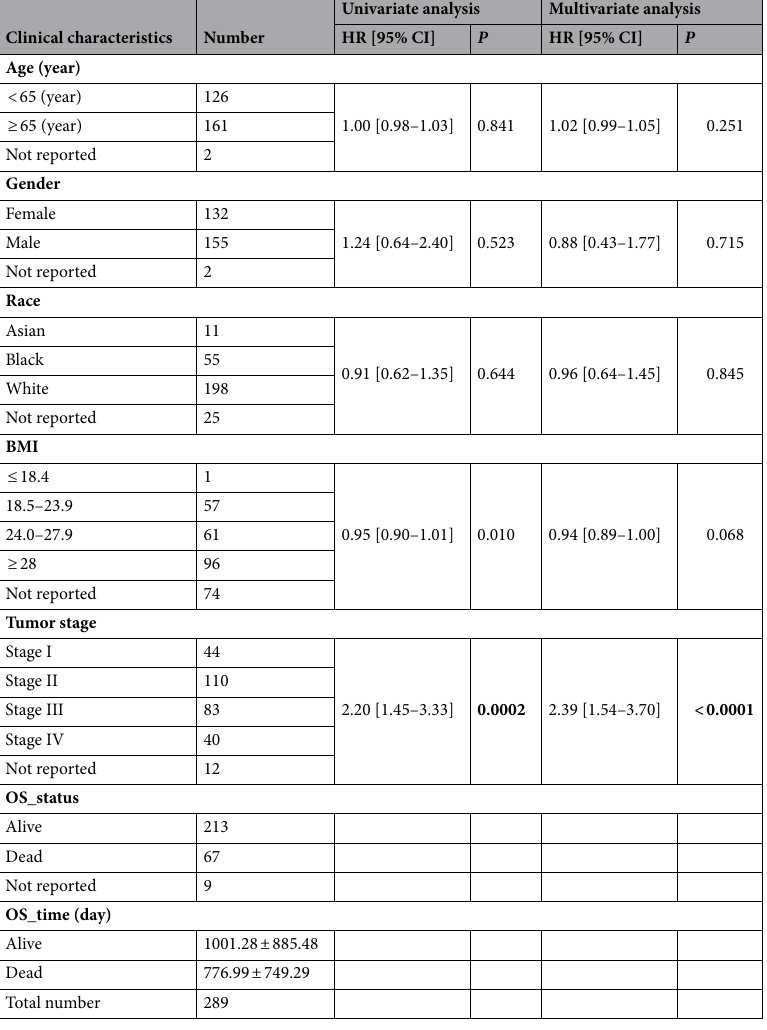
Table 1. Clinical characteristics of COAD cases (data from the TCGA database), as well as Cox regression analysis of the clinical parameters. BMI body mass index, OS overall survival, HR hazard ratio, CI confidence interval. Significant values are in